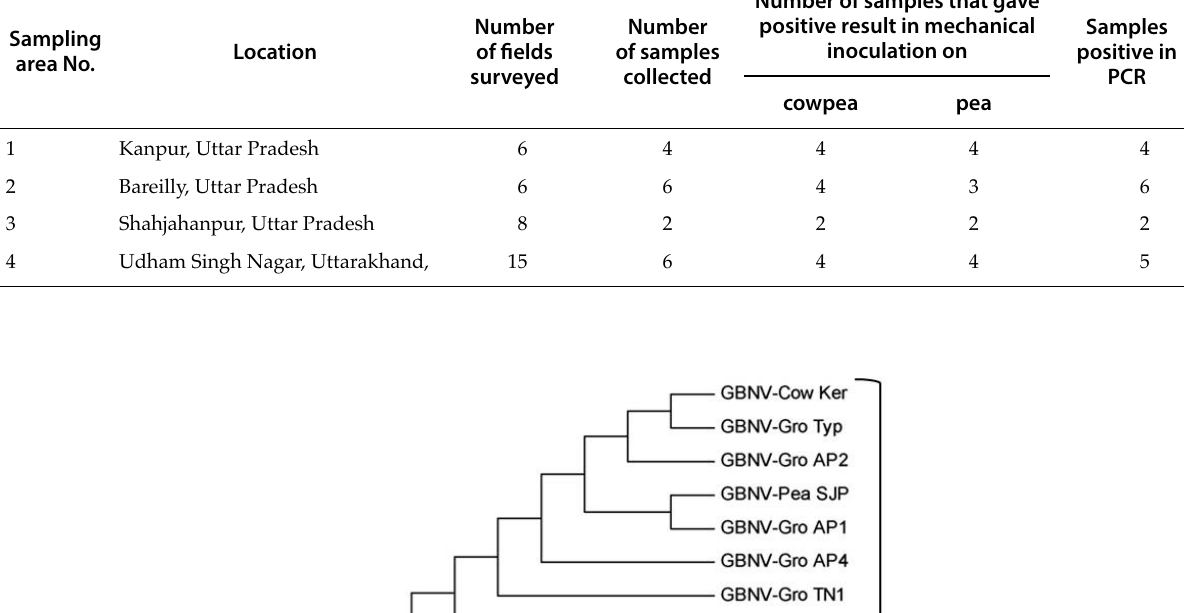
Sampling area No.